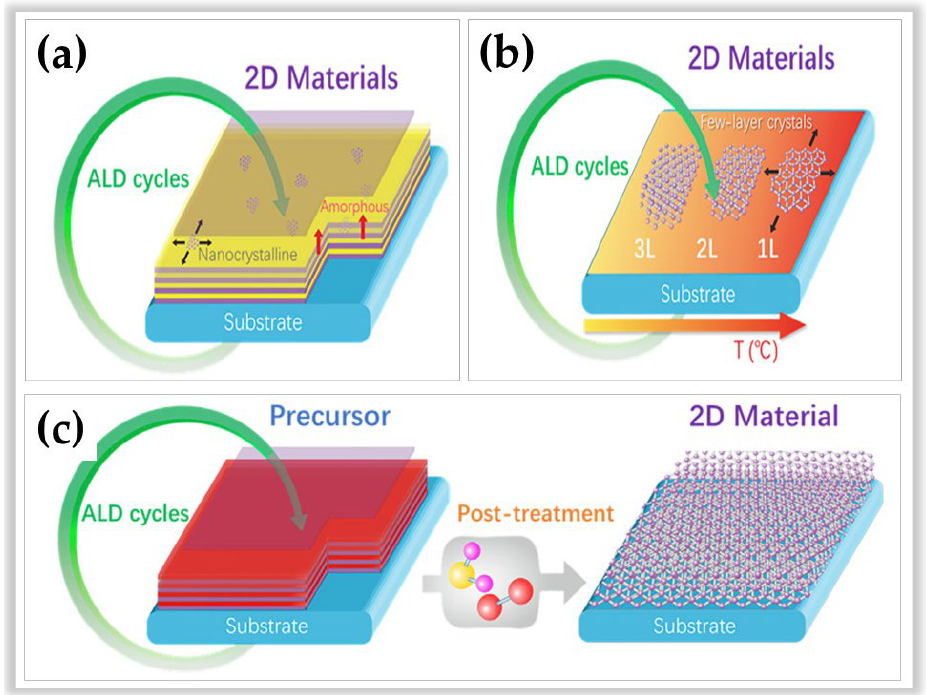
Figure 12. Schematic illustrations of three strategies for growth 2D materials via atomic layer deposition. Subfigure ( a ) represents method 1. Subfigure ( b ) represents method 2. Subfigure ( c ) represents method 3. Reprinted with permission from Ref. [118]. Copyright 2020, Elsevier.